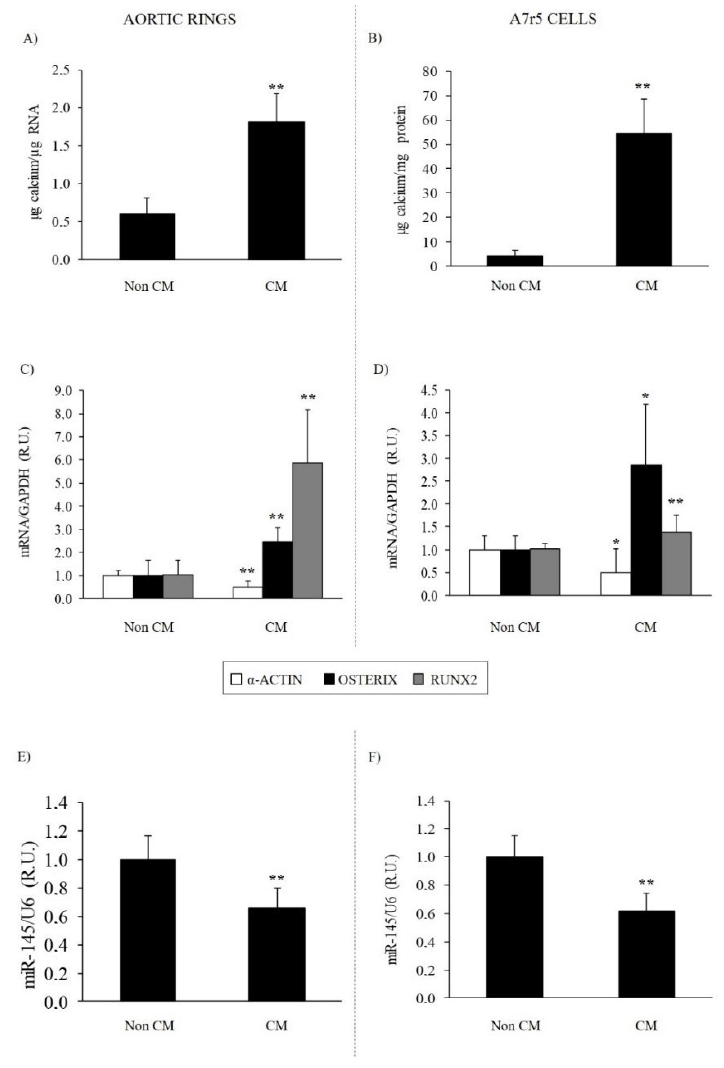
Figure 3. Calcification and osteogenic differentiation in aortic rings and VSMC under calcifying conditions. Ca deposition in aortic rings ( A ) and A7r5 cells ( B ) exposed to non-calcifying media (Non CM: 1 mM Ca; 1 mM P) or calcifying media (CM: 2mM Ca; 3mM P) for 4 days. Gene expression of α –actin (white bars), osterix (black bars) and Runx2 (gray bars) in aortic rings ( C ) and A7r5 cells ( D ) treated as described. Levels of miR-145 in aortic rings ( E ) and in A7r5 cells ( F ) treated as described. Bars and error bars represent mean ± SD from three independent experiments performed in triplicate per experimental condition. R.U.: relative units. * p < 0.05 and ** p < 0.01 vs.